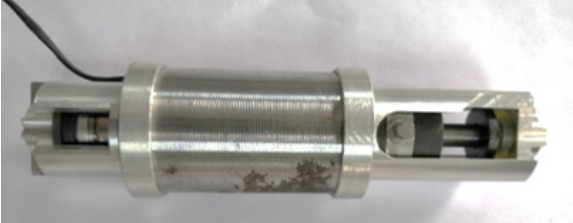
Fig. 15. Physical object of the voice coil linear